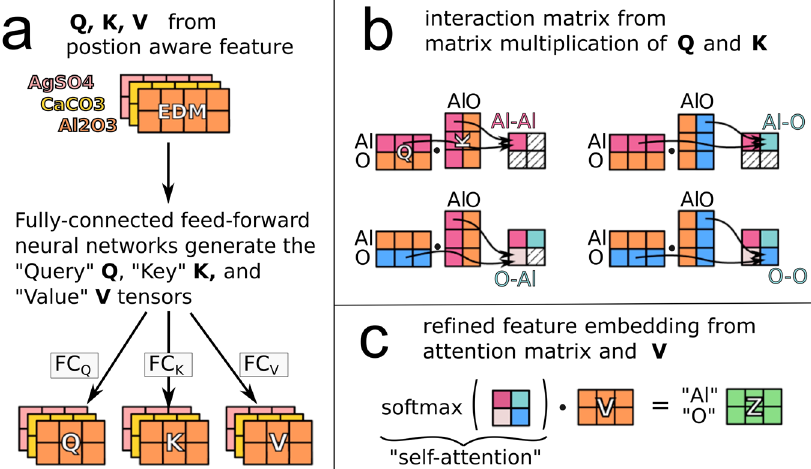
Fig. 13 Illustration of an attention block from CrabNet 90 . a The input position-aware features (i.e., EDM) are fi rst mapped to query ( Q ), key ( K ), and value ( V ) matrices by the corresponding fully connected layers. b Q and K are multiplied to give the interaction matrix. This matrix multiplication operation is inspired by the fact that dot product shows the distance between vectors. c The interaction matrix is scaled and normalized to give the self-attention matrix, which is then combined with V to generate the re fi ned feature representation Z . Z is further re fi ned by passing through a shallow feed-forward network, which is not shown here. Figure reprinted from ref. 90 under the CC BY 4.0 license 156 .